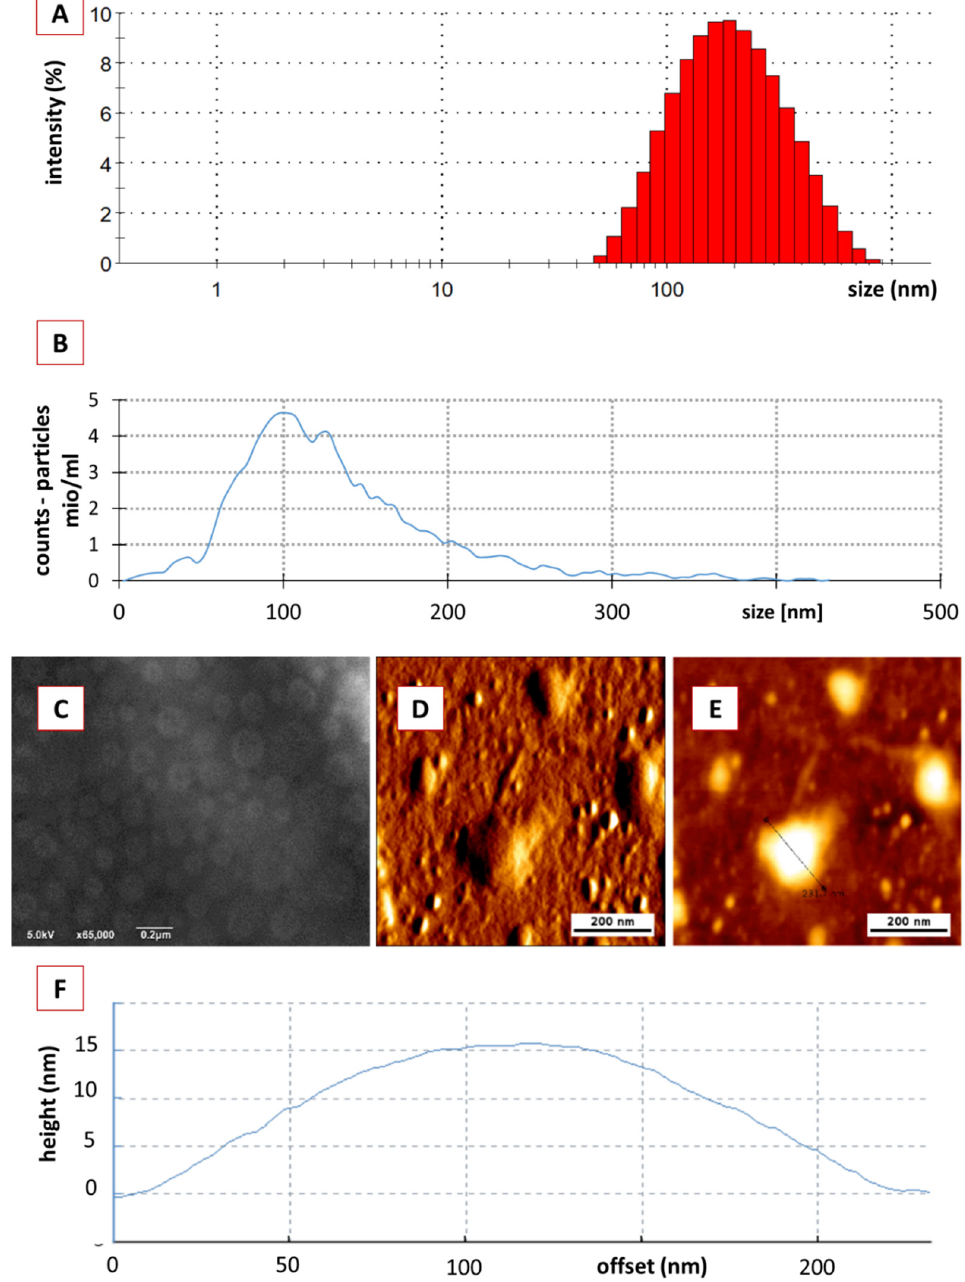
Figure 2. Physico-chemical characterization of crude classical PEVs. ( A ): DLS data, ( B ): NTA data, ( C ): SEM analysis, ( D – F ): AFM analysis.